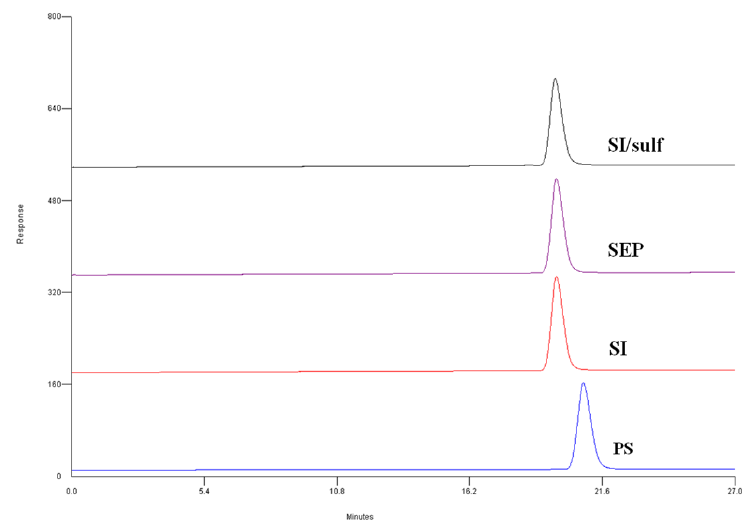
Figure 1. SEC chromatograms of the synthesized materials where the color blue corresponds to the PS homopolymer precursor, red to the SI diblock copolymer, purple to the hydrogenated SEP sample and black to the sulfonated SI/sulf copolymer.